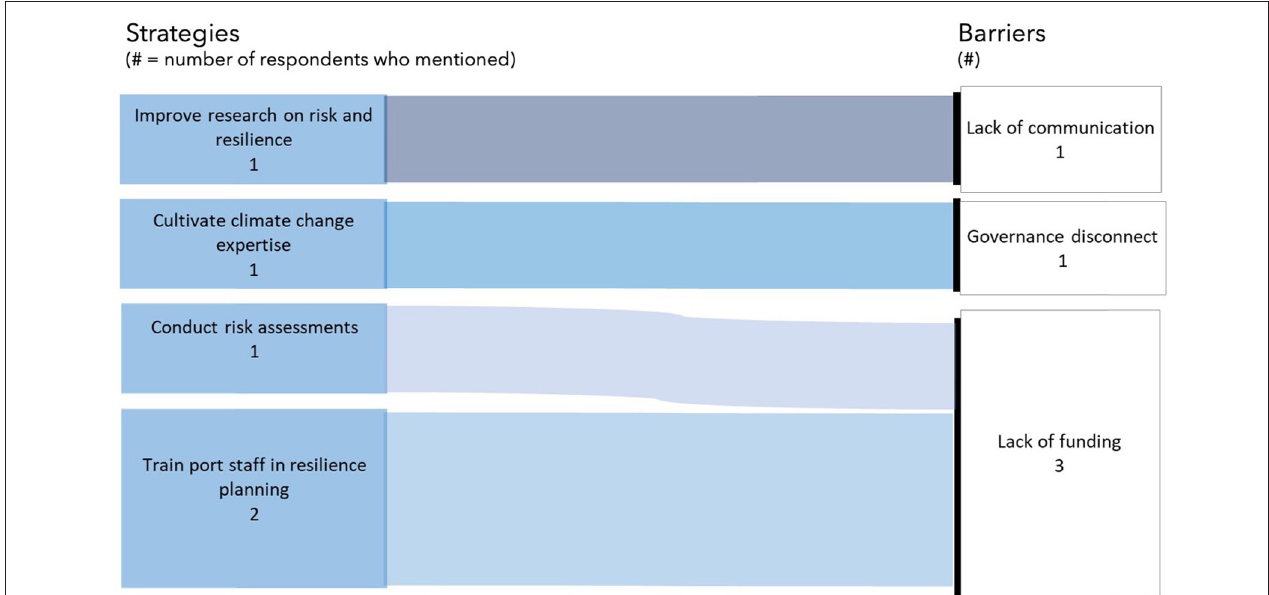
FIGURE 5 | Research and education strategies (left side) to overcome identified barriers (right